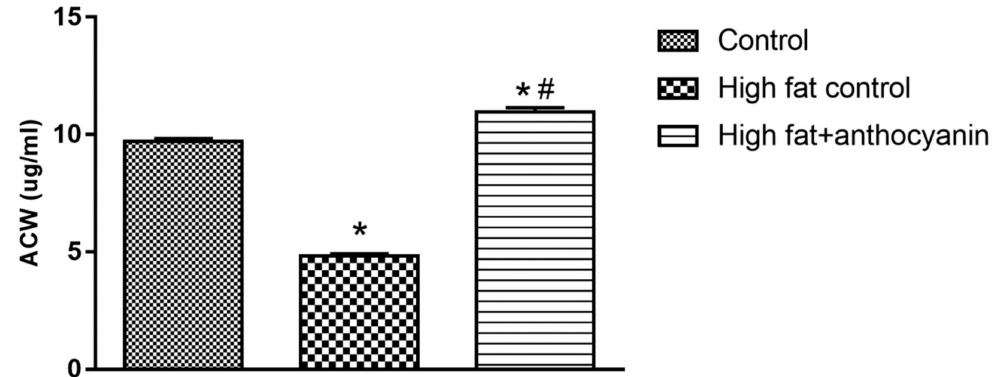
Figure 6. E ff ect of chronic anthocyanin treatment on water-soluble antioxidant capacity (ACW) in the blood. The * indicates a significant di ff erence ( p < 0.05) from the control group. The # indicates a significant di ff erence ( p < 0.05) between the high fat control and the high fat + anthocyanin